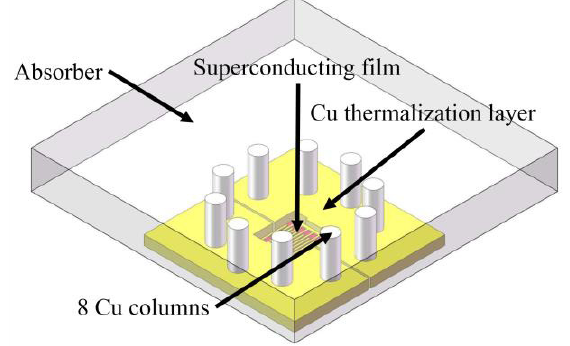
Fig. 3. The structural diagram of Model A. Removed the Si substrate and the Si 3 N 4 film compared to complete TES.